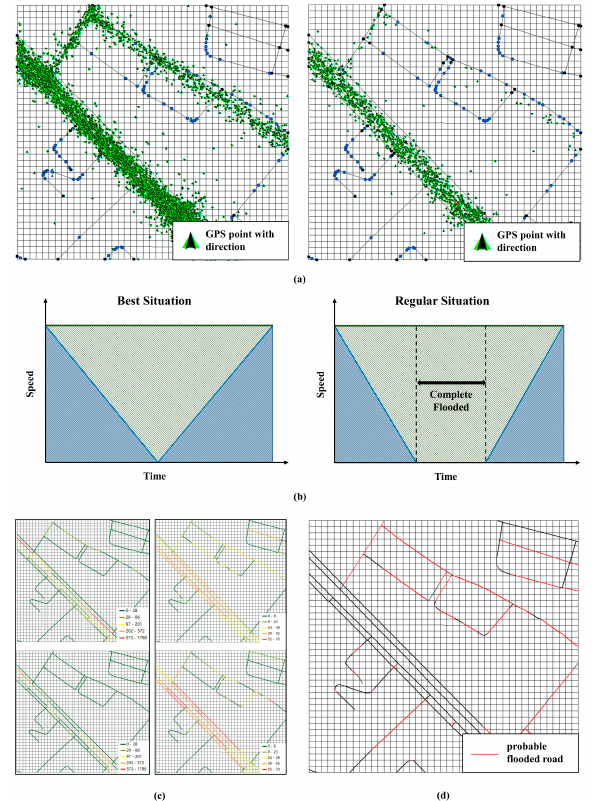
Figure 6. The workflow of extracting probable flooded roads by comparing the difference between normal and rainy days. ( a )-Left shows the distribution of directed points on the sunny day; -right shows the distribution of directed points on the rainy day. ( b )-Left is the best situation for flooded roads, and the average speed decline is about 0.5; -right is the regular situation, where decline is more than 0.5. ( c )-Left shows the difference in density with the same symbol system on normal and rainy days; -right shows the difference in average speed with the same symbol system. In ( d ), red lines represent the probable flooded roads and black lines represent normal roads.